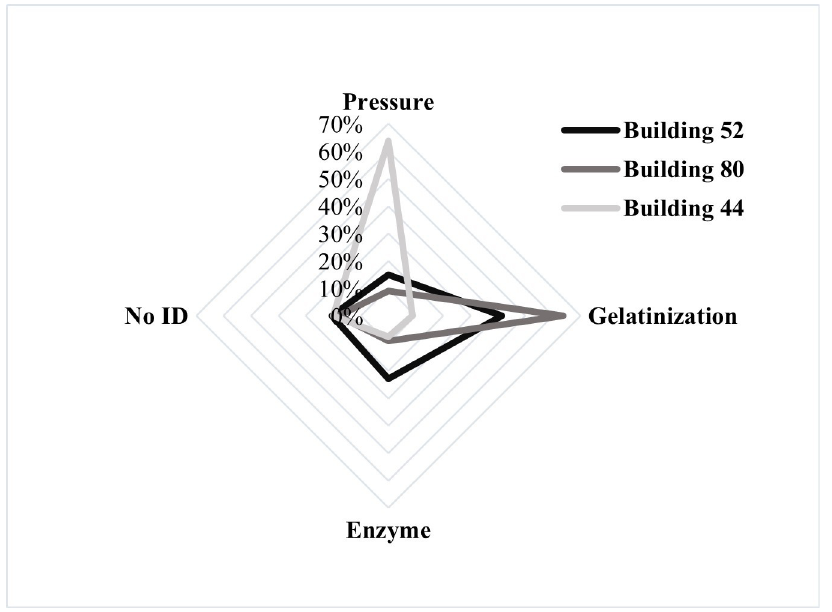
Fig 7. Starch damage. Proportions and distribution of starch damage by